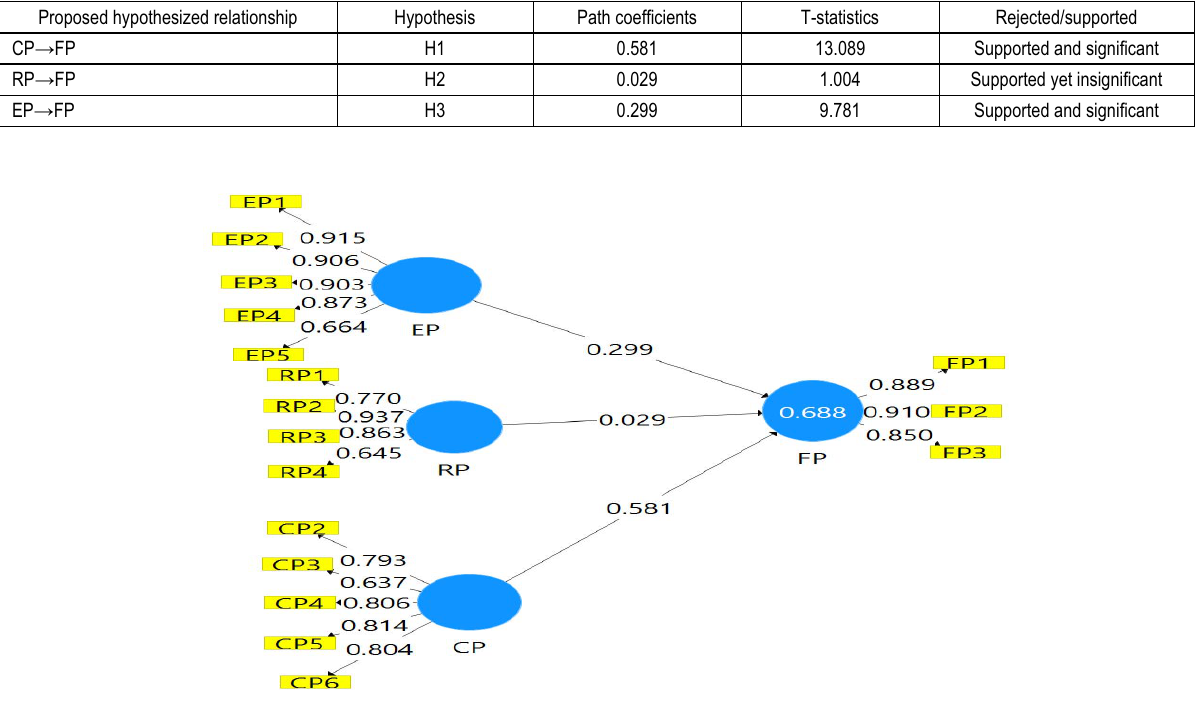
Table 3. Summary results of the structural equation model analysis